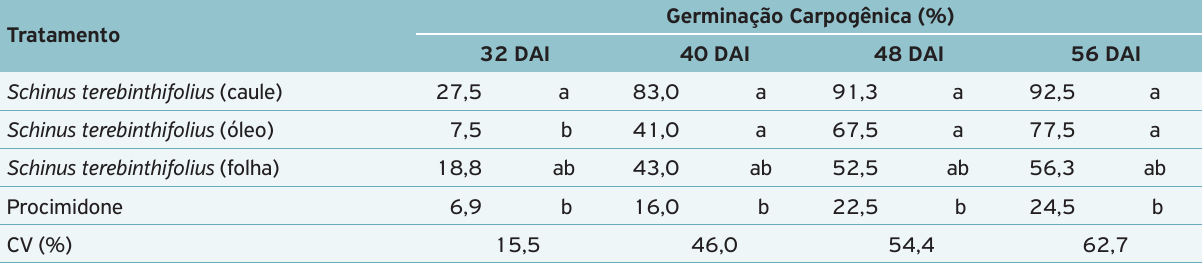
Tabela 6. Germinação carpogênica (%) de S. sclerotiorum sob extratos metanólicos, óleo essencial (1.000 ppm) de